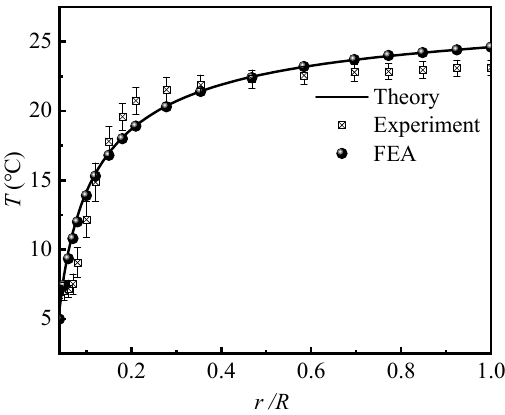
Figure 3. Temperature distribution along Path 1.